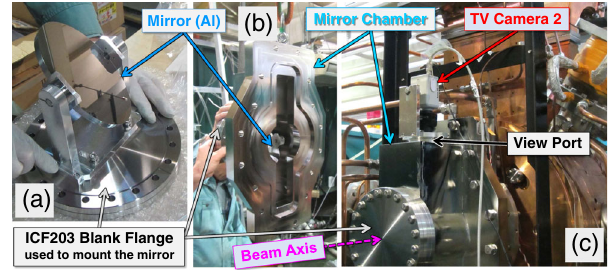
FIG. 4. Mirror chamber used for the high-gradient test of DR cavity No. 2. (a) Aluminum elliptical mirror mounted on an ICF203 blank flange. The surface was finished by lapping, ≈ 1 nm. (b) Stainless steel vacuum chamber con- yielding R a taining the mirror. The inner surface of this chamber was electropolished. (c) Mirror chamber attached to DR cavity No.